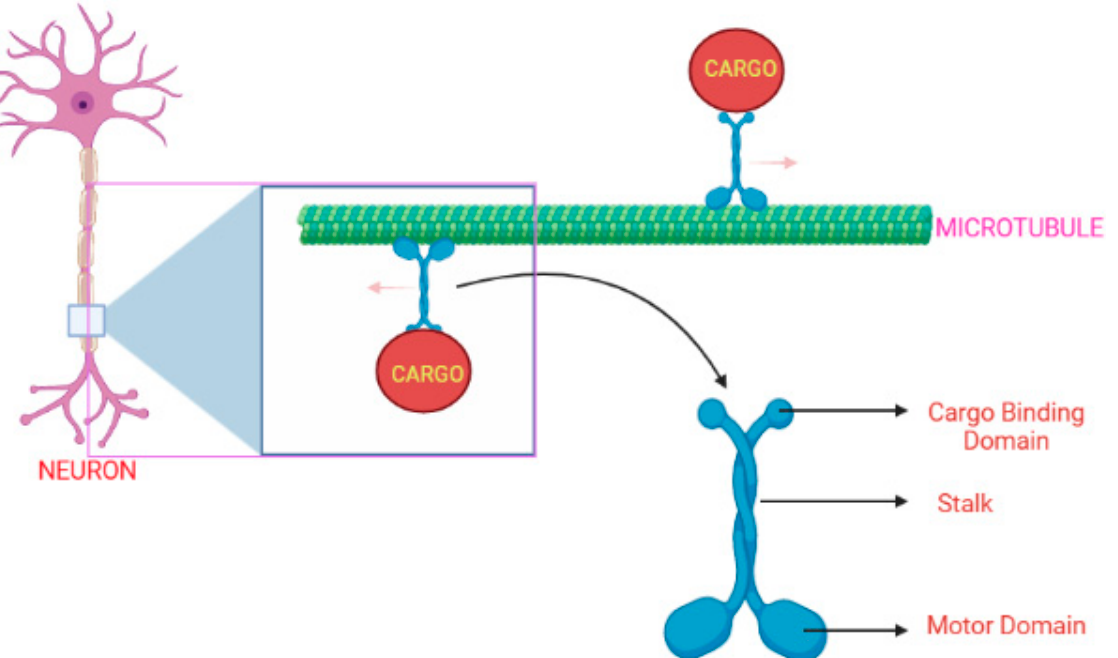
Figure 2. The KIF1A protein’s typical shape and movement along the MT surface in a healthy neuronal cell [15] . (Created with Biorender.com).